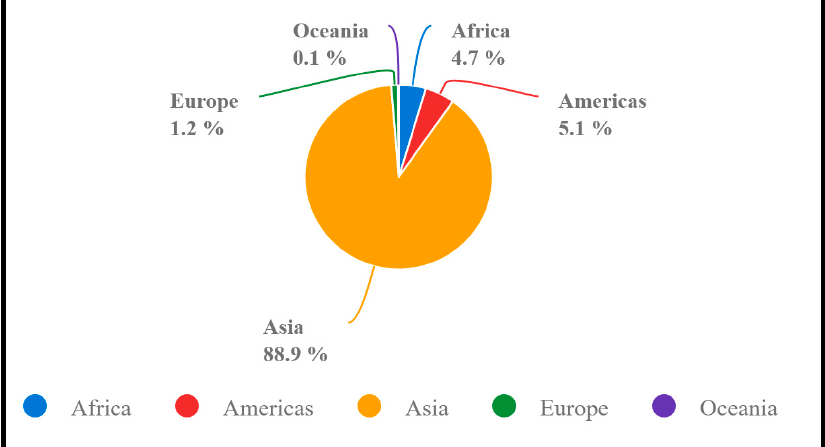
Figure 7. Share of emissions (CO 2 eq (AR5)) by continent, rice cultivation in 2019 [162].